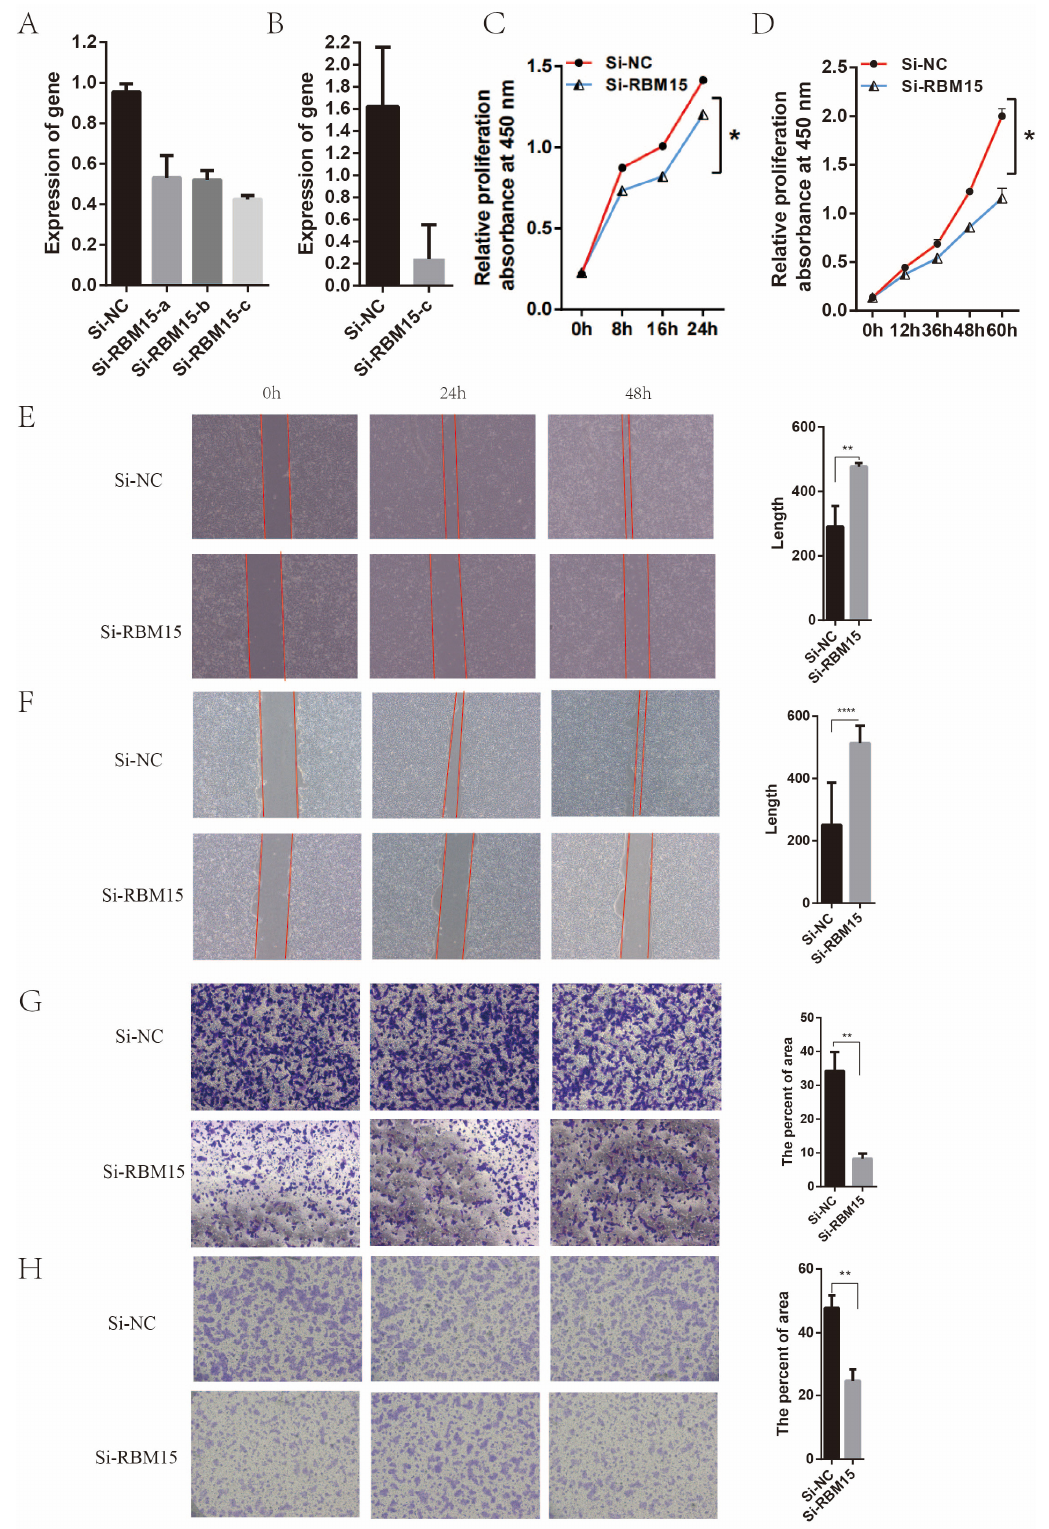
Figure 7. ( A ) Efficiency of different Si-RNAs in knocking down RBM15 for CFPAC-1; ( B ) Efficiency of Si-RBM15-c in knocking down RBM15 for BxPC-3; ( C , D ) Results of CCK-8 experiment in cell lines CFPAC-1 and BxPC-3 after RBM15 gene knockdown; ( E , F ) Scratch assay in cell line CFPAC-1 and BxPC-3; ( G , H ) Results of Transwell experiments in cell lines CFPAC-1and BxPC-3 (* p < 0.05; ** p < 0.01; **** p < 0.0001).